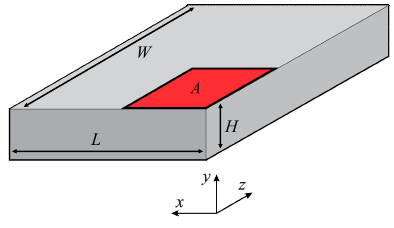
Figure 1. Transient 3D heat conduction problem.